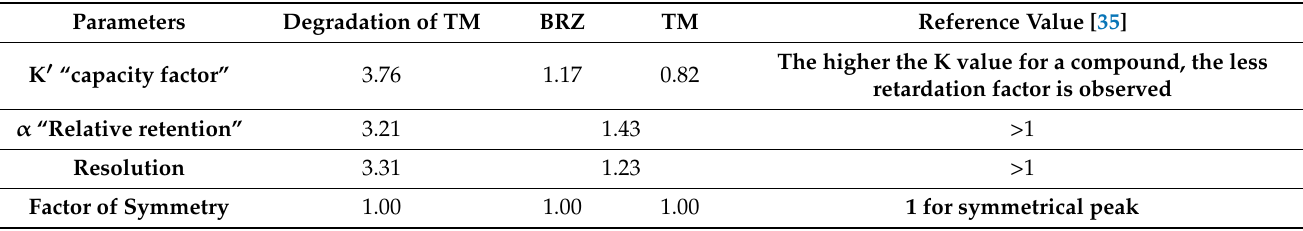
Table 5. Data for Suitability of the System for the TLC-Densitometric Method (MI).